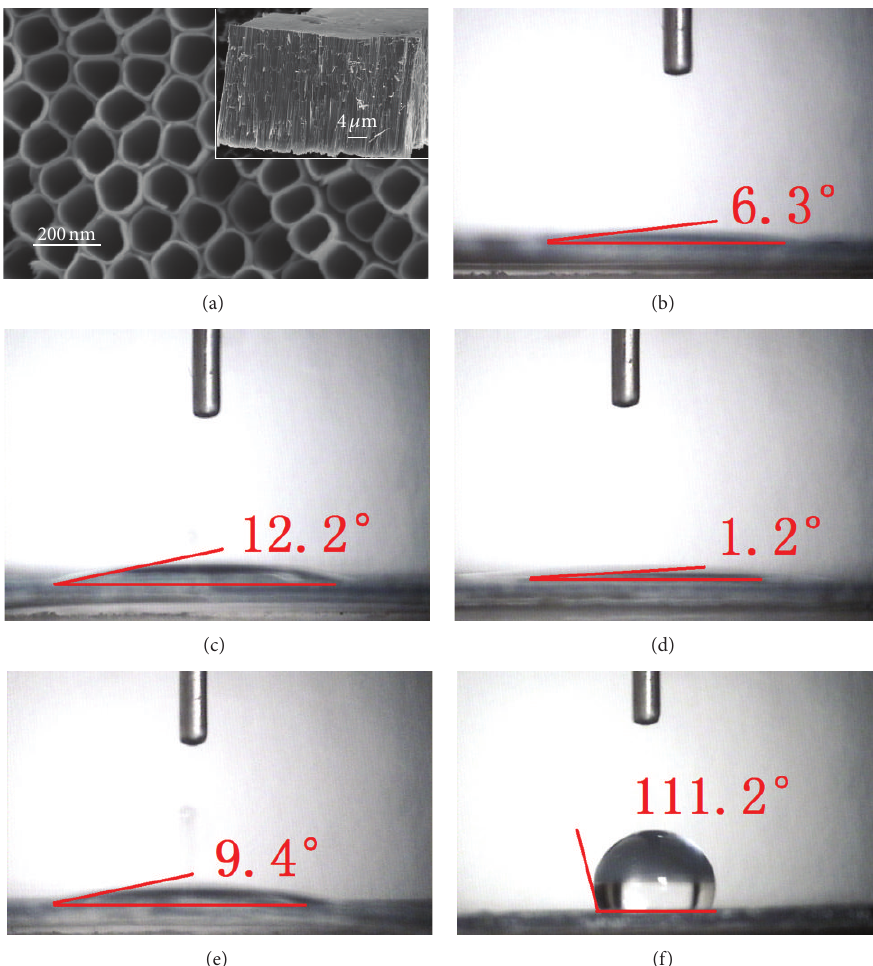
Figure 1: (a) Top-view SEM image of the TNAs with the corresponding side-view image in the inset. (b) Contact angle of the reference TNAs sample. Contact angles of the TNAs modified by (c) TiCl 4 , (d) HNO 3 , (e) KOH, and (f)